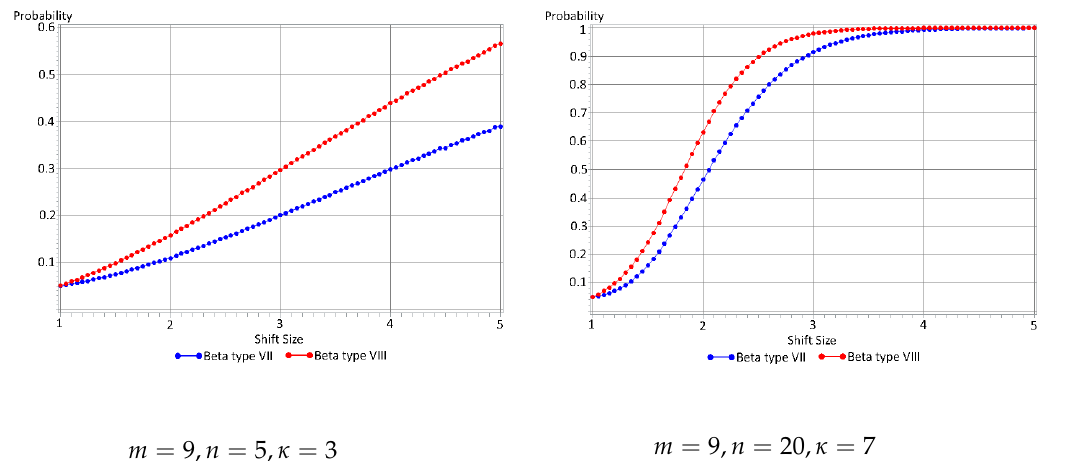
Figure 8. Probability of detecting a shift when m = 9.